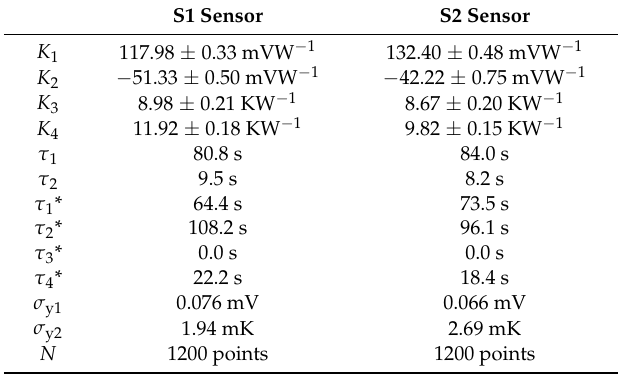
Table 1. Results of the calibration of each minisensor (Equations (1) and (2) parameters) and mean squared errors of the adjustment (Equation (4)).